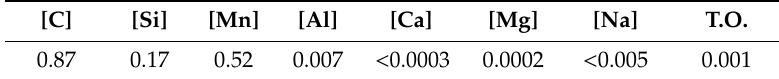
Table 2. Composition of initial steel (wt%).